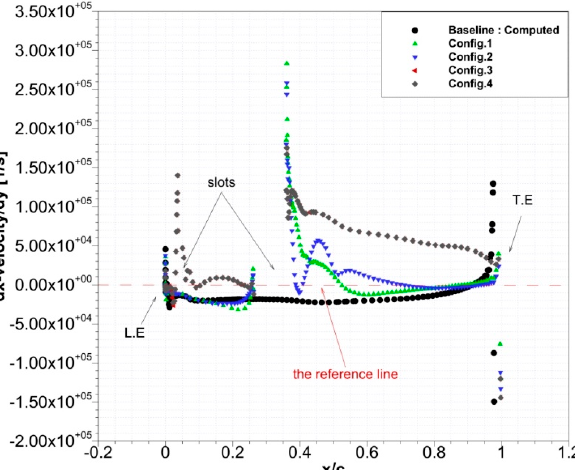
Figure 17. The distribution of the relative velocity derivative in the normal direction to the upper side of the blade for S-S, T-S, and baseline configurations, r/R = 0.5 and wind-speed U ∞ = 19 m s − 1 . This section compares the boundary layer separation for the four configurations (two S-S and two T-S configurations) with the baseline. We used the derivative in the direction normal to the wall of the relative flow velocity on the blade in the x-direction as a criterion to detect separation. If this derivative is positive, the boundary layer is attached. If it is negative, the boundary layer is detached. Figure 17 illustrates this derivative’s distribution on the blade’s upper side at r/R = 0.5 and wind-speed U ∞ = 19 m s − 1 . The negative values below the reference line represent separated flow, while positive values above the reference line represent the attached